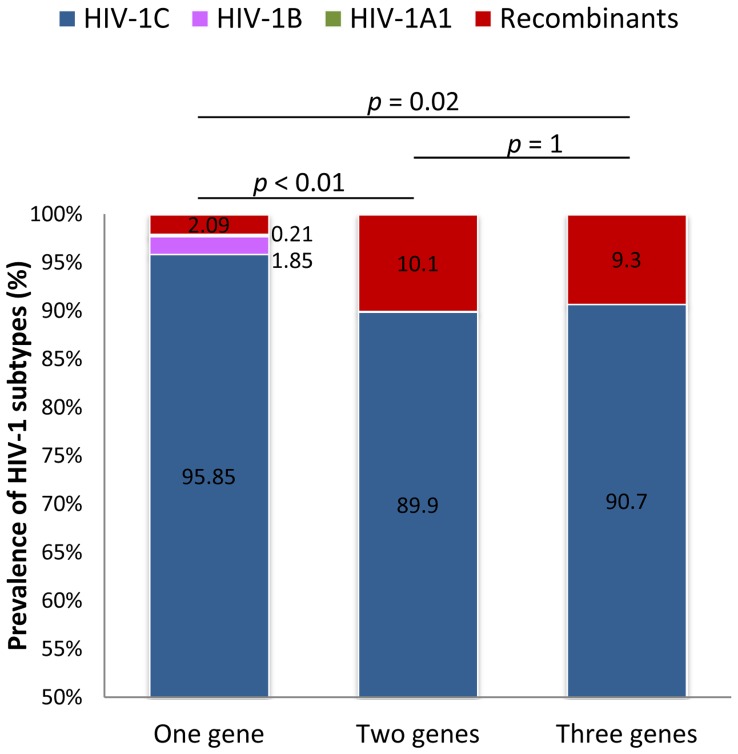
Prevalence of HIV-1 subtypes and recombinant forms in India based on one gene, two and three genes.The p values are presented along with the values for the predominant HIV-1C and recombinants. Subtyping was carried out as described in the methods section. For sequences that indicated an event of recombination, bootscan analysis was performed in Simplot version 3.5.1 using 100 nucleotide window size and 20 nucleotide step size to map the precise breakpoint. The recombination event was further confirmed by region-specific phylogenetic analysis using ML tree in MEGA 5.